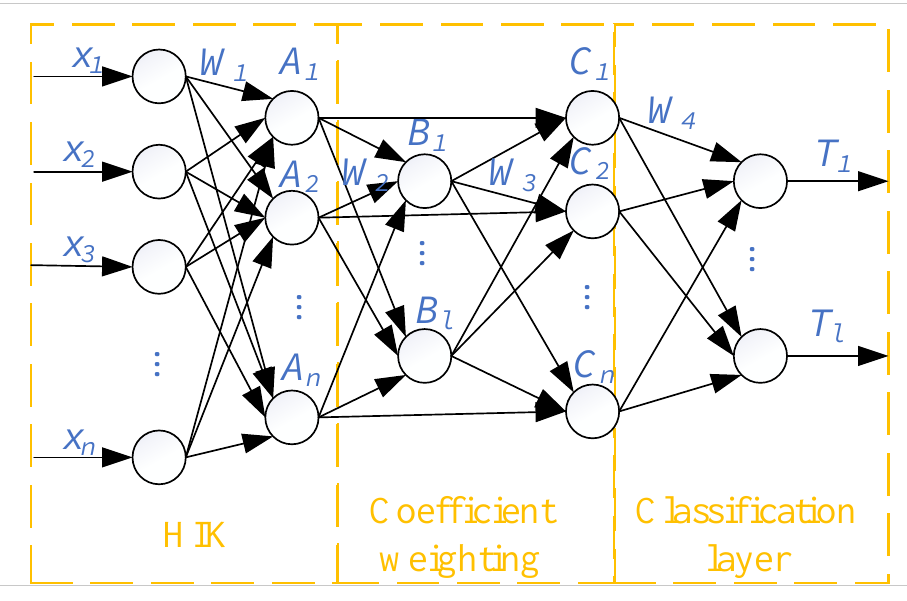
Figure 7. The structure of